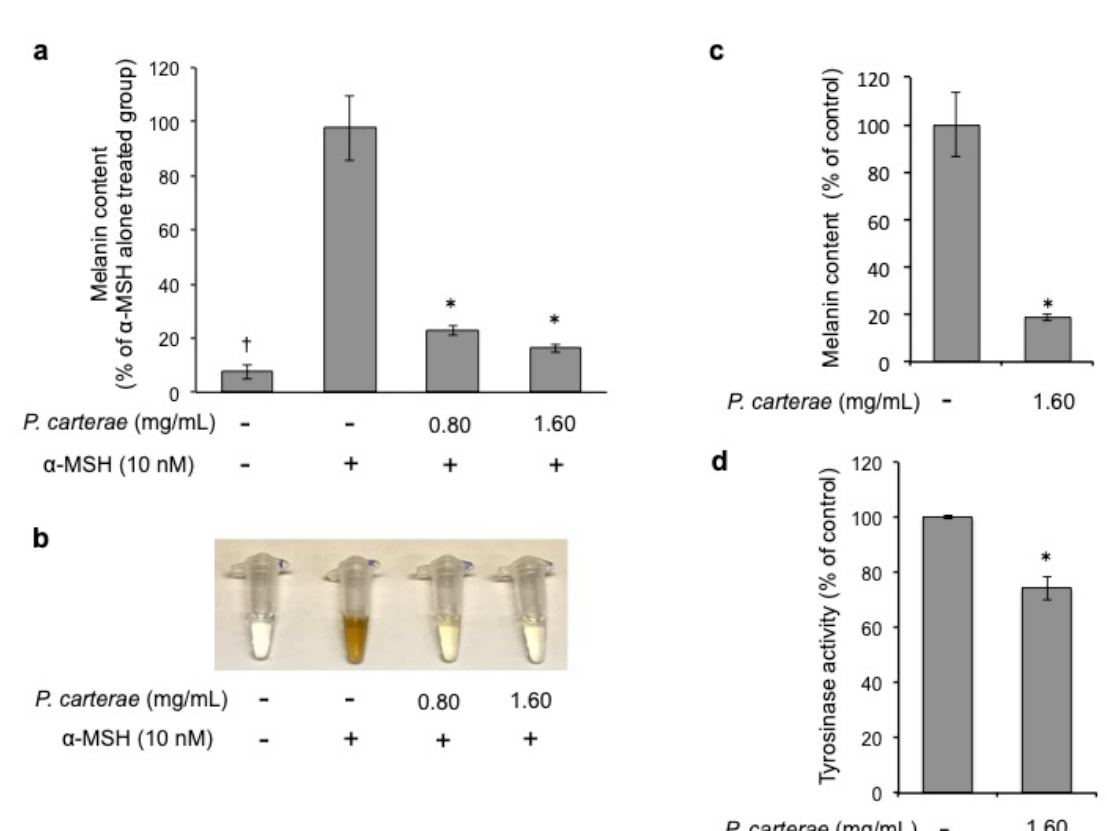
Figure 4. E ff ect of P. carterae extract on melanin synthesis and mushroom tyrosinase activity. ( a ) B16F1 melanoma cells were treated with or without P. carterae extract in the presence of α -melanocyte-stimulating hormone ( α -MSH) (10 nM) for 4 days, and the melanin content was measured. † p < 0.01 versus vehicle control, * p < 0.01 versus α -MSH-only- treated. ( b ) After treatment, the cells were solubilized in 2 M NaOH and then photographed. ( c ) B16F10 melanoma cells were treated with or without P. carterae extract for 4 days, and the melanin content was measured. * p < 0.01 versus vehicle control. ( d ) E ff ect of P. carterae extract on mushroom tyrosinase activity was measured. Results are expressed as the percentage of the control.